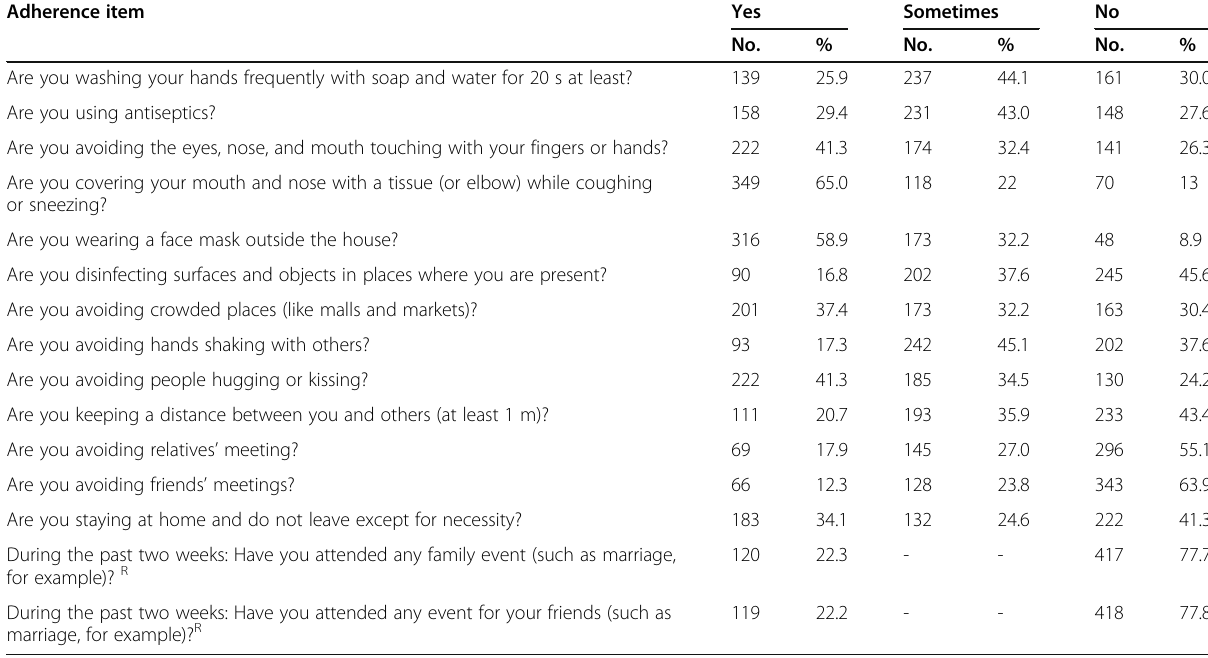
Table 3 Adhrence to COVID-19 preventive measures among male students at Al-Azhar Faculty of Medicine, Cairo, Egypt, 2021 Adherence